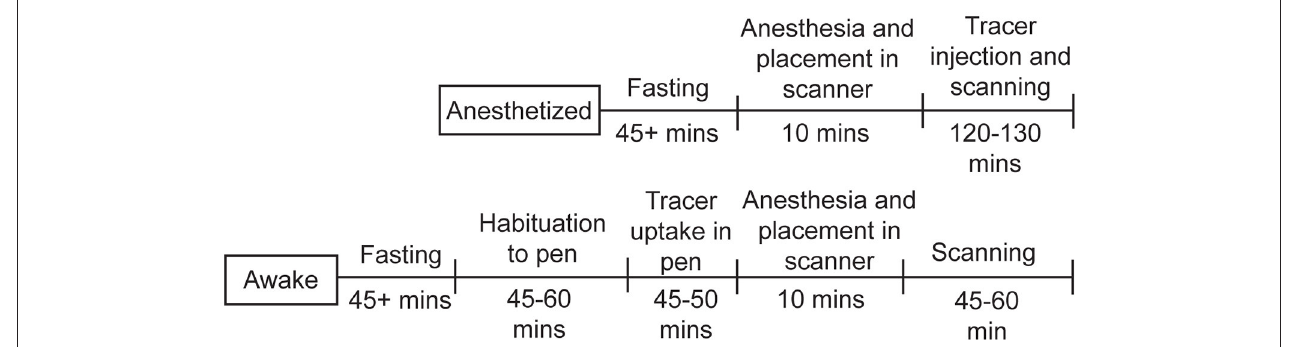
FIGURE 3 | Timeline for chicken studies. For the studies under anesthesia, the chickens were fasted for at least 45min, then anesthetized, injected with 18 F-FDG, and scanned for up to 130min. For the awake studies, the chickens were fasted for at least 45min, allowed to habituate to the pen, injected with 18 F-FDG and given time for uptake, then anesthetized and scanned for up to 60min.